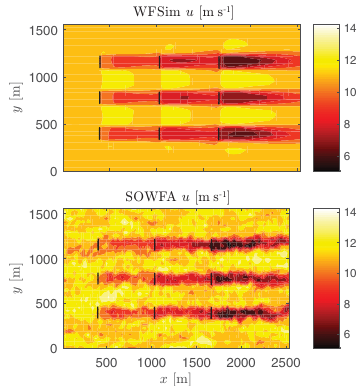
Figure C1. Flow field obtained with SOWFA (below) and WFSim at t = 250(s). The black lines indicate the turbines.